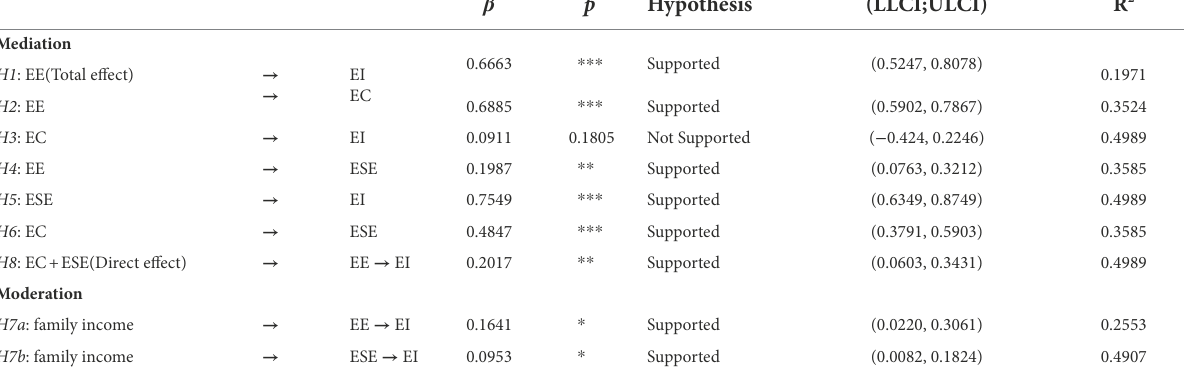
TABLE 5 Bootstrapped moderated-mediation